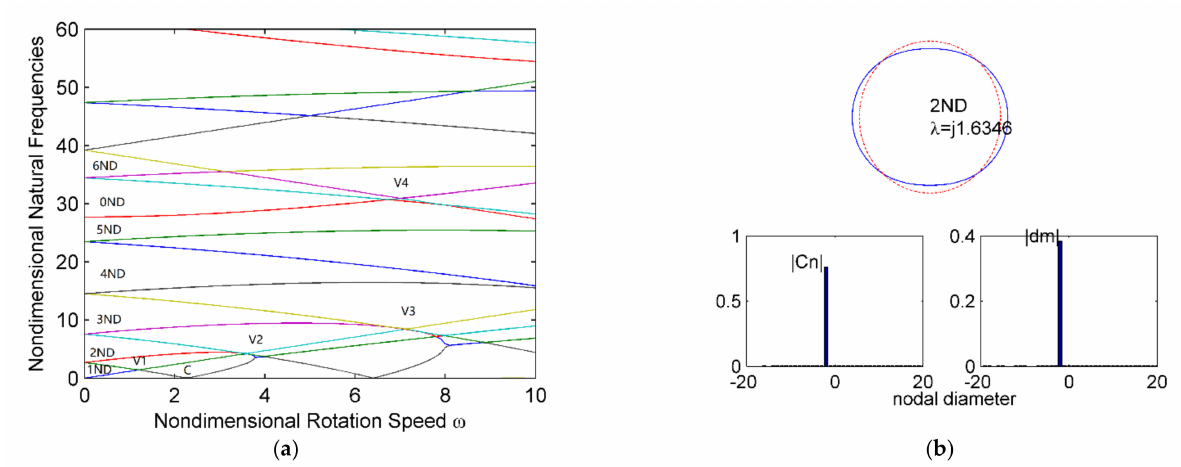
Figure 3. ( a ) Natural frequencies of a free planet ring versus varying speed; ( b ) representative vibration mode and its components at speed ω = 1 (dash line = original position; solid line = vibration